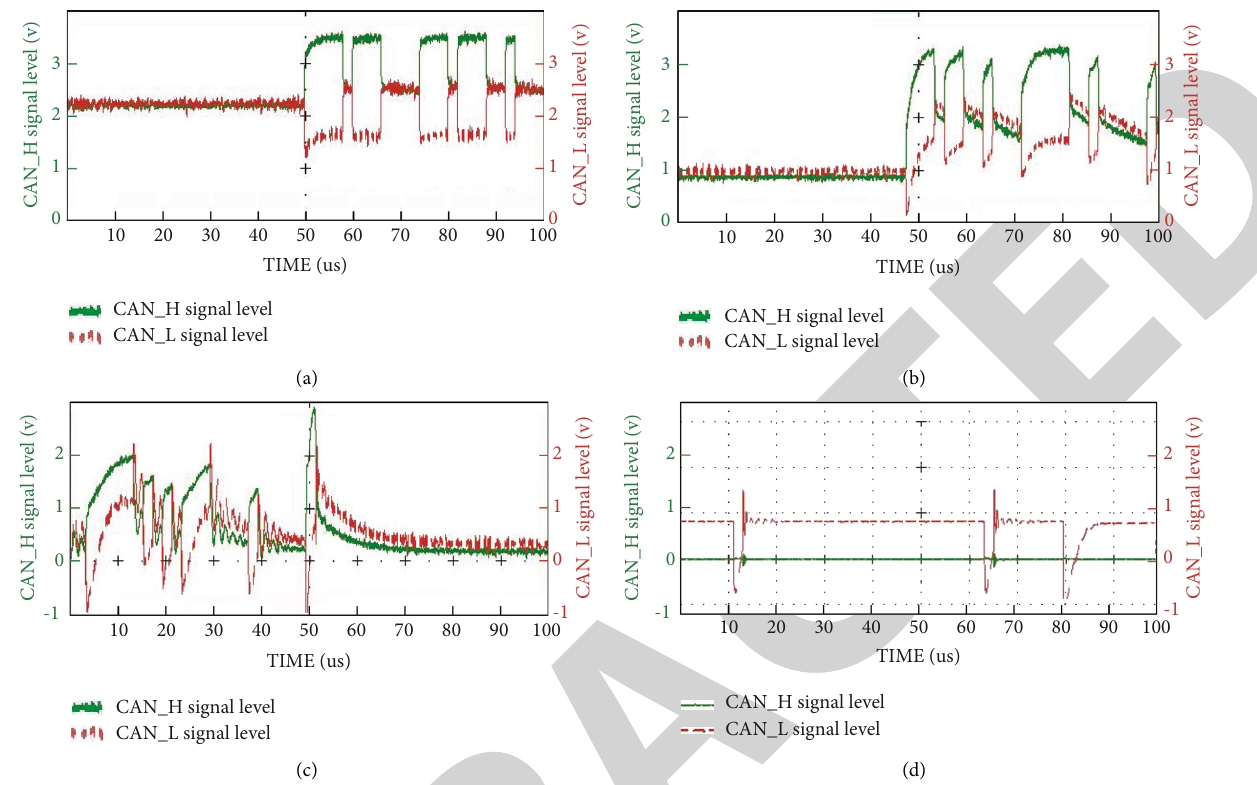
Figure 3: Signal waveform of PT-CAN_H to ground loaded with different resistance. (a) PT-CAN _ H load resistance to ground with 2.5k Ω . (b) PT-CAN _ H load resistance to ground with 250 Ω . (c) PT-CAN _ H load resistance to ground with 37 Ω . (d) PT-CAN _ H load resistance to ground with 0 Ω